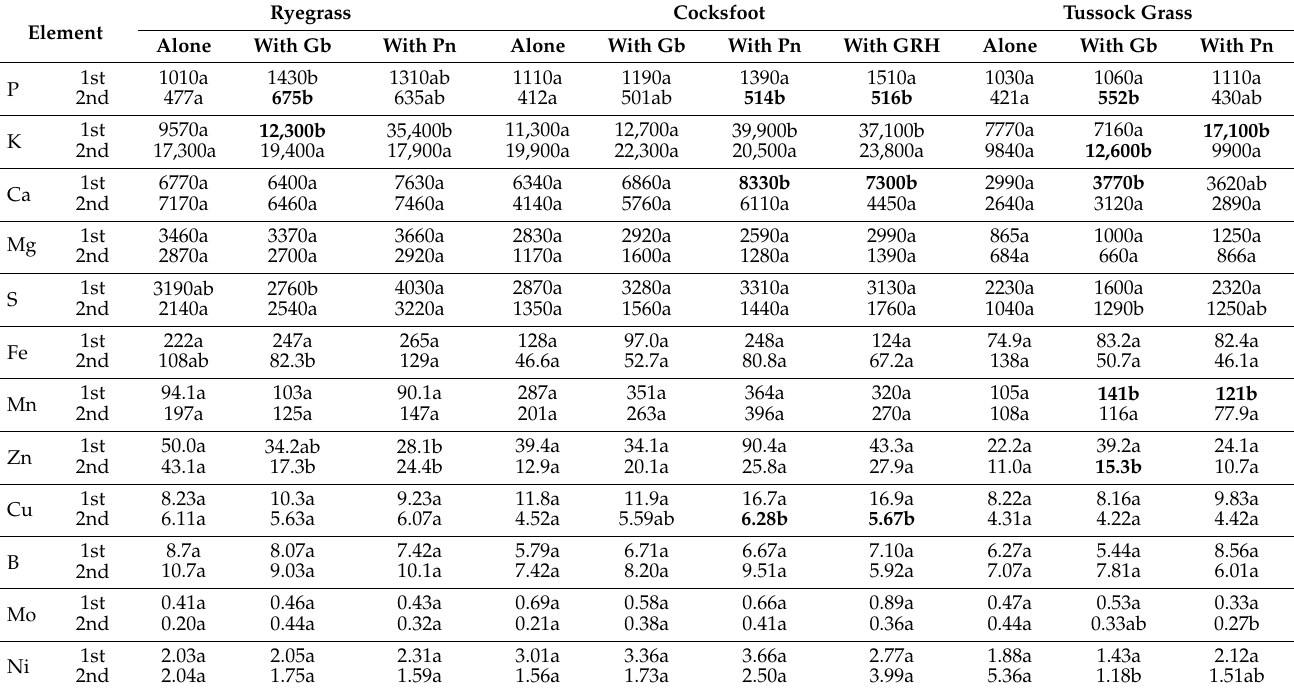
Table A2. Nutrient concentration in grass foliage when they were growing alone or with proteas (Gb: Grevillea barklyana , Pn; Protea neriifolia , GRH; Grevillea Robin Hood) at 1st and 2nd sampling events. Different letters each indicate significant differences ( p < 0.05) within each treatment. Bold alphanumericals indicate significant differences to when the species was growing alone.